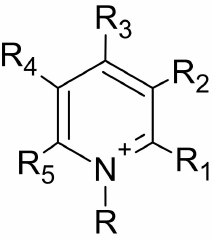
Figure 5. Pyridinium